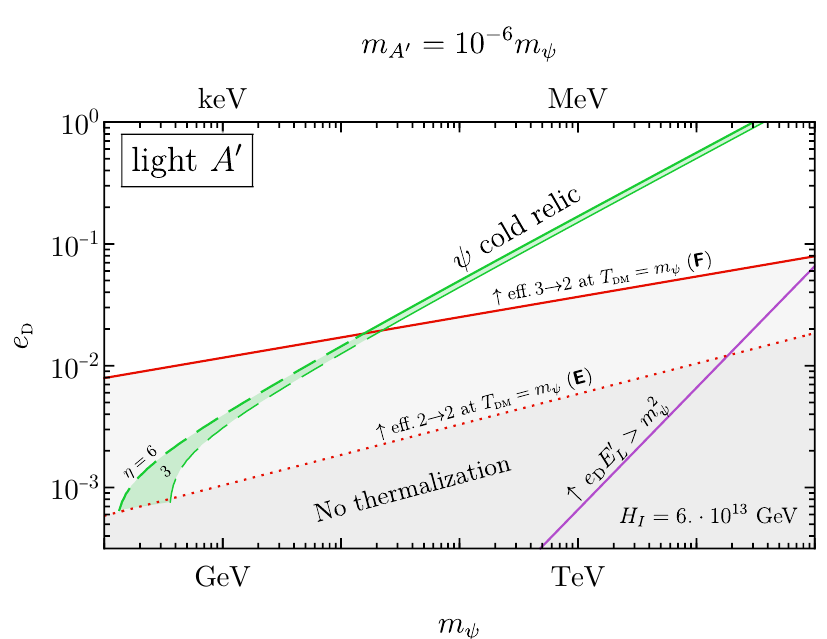
Figure 6. Parameter space where ψ achieves the DM relic abundance via freeze-out for light dark photons ( m A 0 = 10 − 6 m ψ ). The dark sector fully thermalizes when 3 → 2 processes like F in figure 4 are efficient at late times, which occurs for large enough e d as given in eq. (3.11), marked by a red solid line (a more detailed account can be found in sections 3 and E). The condition of kinetic equilibrium at late times, when 2 → 2 processes like E are efficient, is shown with a red dotted line and marks the region below which the final state of the dark sector appreciably deviates from the thermal one. The green line (plotted for η = 3 and η = 6 ) identifies where ψ reaches the DM relic abundance as a cold relic through freeze-out. The line is solid where we can fully trust the thermal relic calculation, and becomes dashed when O (1) deviations could appear. Finally, the purple line marks where the dark electric field at horizon crossing at early times is larger than the critical field, see the discussion in appendices B and